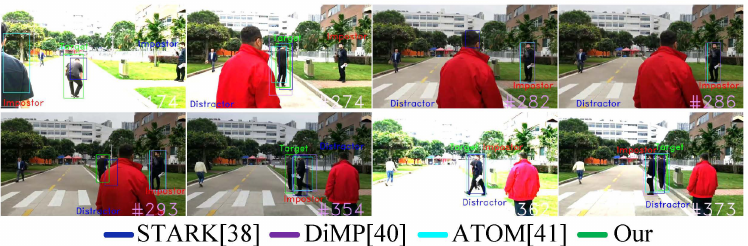
Figure 24. Person-Following Tests in Scenario#3 (seq#3), where the Target moves in varying illumina- tion environment, while the Target is completely occluded with impostors and distractors, and also suffers due to changing